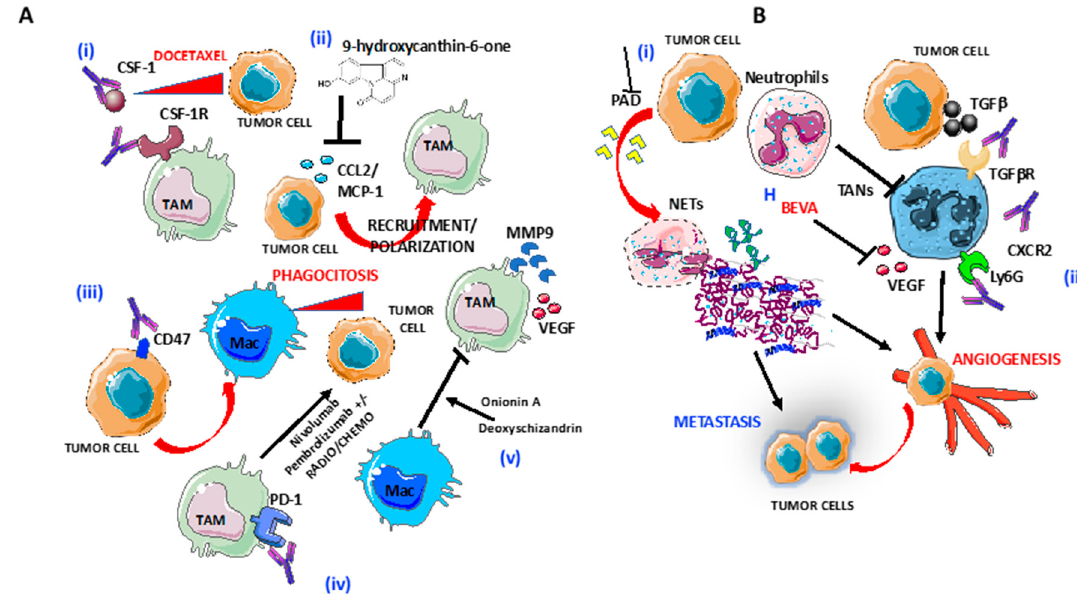
Figure 2. Targeting of macrophages and neutrophils in OvCA: ( A ) Several strategies to target tumor-associated macrophages (TAMs) are shown: (i) blocking of CSF-1R by anti-CSF1 mAbs induce increased responsiveness of tumor cells to Docetaxel; (ii) blocking of CCL2 release by 9-hydroxycanthin-6-one inhibit TAMs recruitment and polarization; (iii) selective blocking of CD47 on tumor cells macrophage infiltration and phagocytosis of ovarian tumor cells; (iv) anti-PD1 Nivolumab and Pembrolizumab in combination with radiotherapy and chemotherapy enhance tumor cells lysis; and (v) Blocking of M2-like / TAM polarization by as Onionin A, from onions and Deoxyschizandrin, from berries. ( B ) Several strategies to target tumor-associated neutrophils (TANs) are shown: (i) blocking of peptidyl-arginine deaminase (PAD) release by tumor cells inhibits neutrophils extracellular trap formation and (ii) preventing TAN polarization by blocking Ly6G and CXCR2 in combination with checkpoint inhibitors, TGF β R and VEGF, through Bevacizumab.